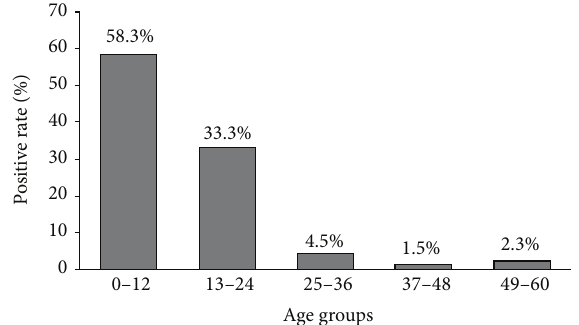
Figure1:AgewisedistributionofHAdV-40andHAdV-41positivity in gastroenteritis